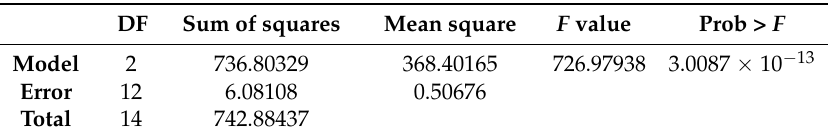
Table 8. Overall analysis of variance of Young’s